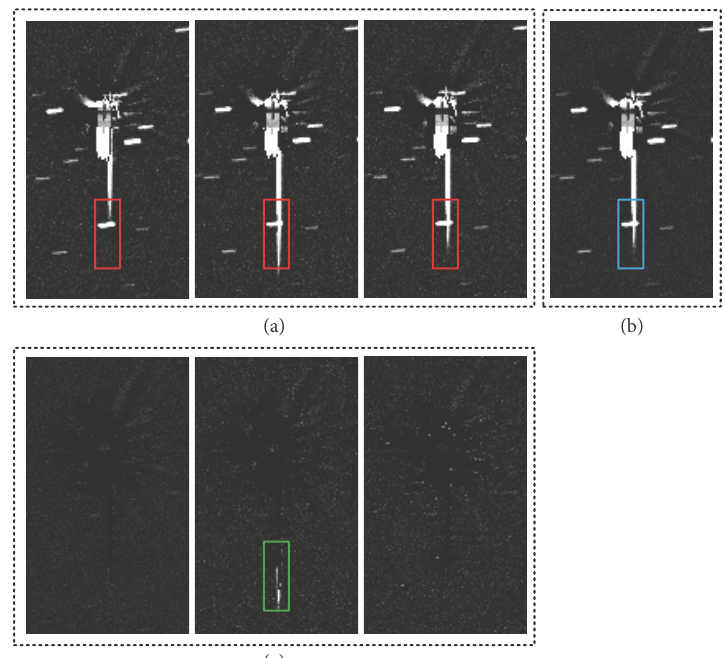
Figure 3: Bright stars flicker in different images. (a) Stars in three consecutive frames. (b) The median frame of (a). (c) The masked frames of (a).